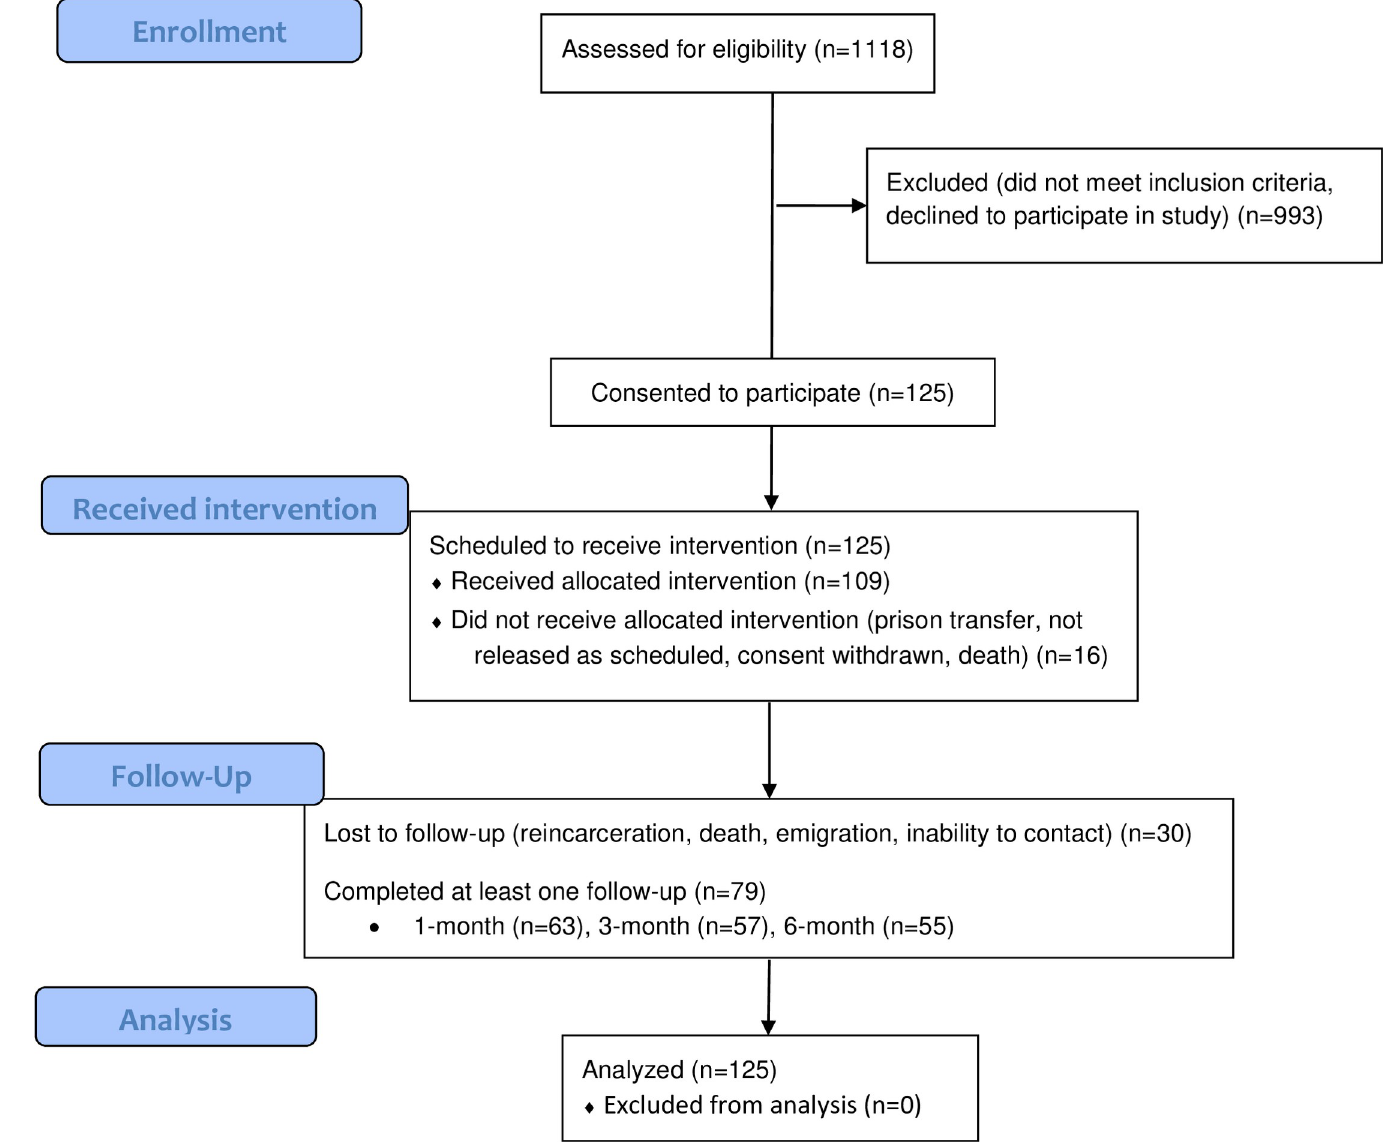
Fig 1. Modified CONSORT [32] flow diagram. 1,118 incarcerated people scheduled to be released within 6 months were screened for opioid use disorder, and 125 screened positive and consented to participate in the study. Of those, 109 completed the full pre-release visit questionnaire, 63 followed up 1 month post release, 57 followed up at 3 months, and 55 followed up at 6 months. Note that some participants did not complete one follow-up visit but returned later in the study; for example, not all of the 55 participants who completed 6-month follow-up had also completed the 3-month follow-up.